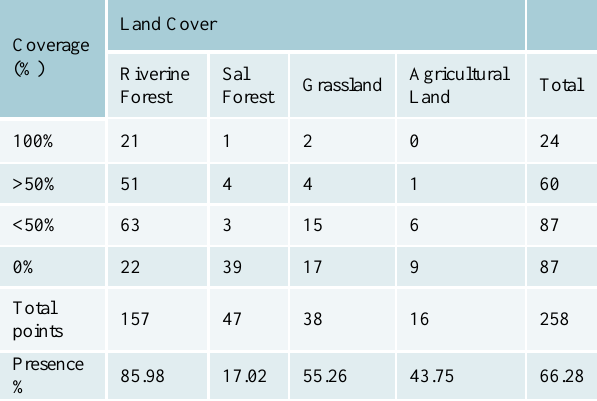
Table 2. Number of sample points in different land cover with respective percentage of Mikania micrantha coverage From the above table, it is concluded that riverine forest has maximum impact of Mikania micrantha that poses the highest risk of invasion within its surrounding. 85.98% of sample points have presence of Mikania micrantha , whereas sal forest has the least percentage of presence points (17.02%). Grassland and agricultural land are moderately affected with 55.26% and 43.75% presence points respectively.